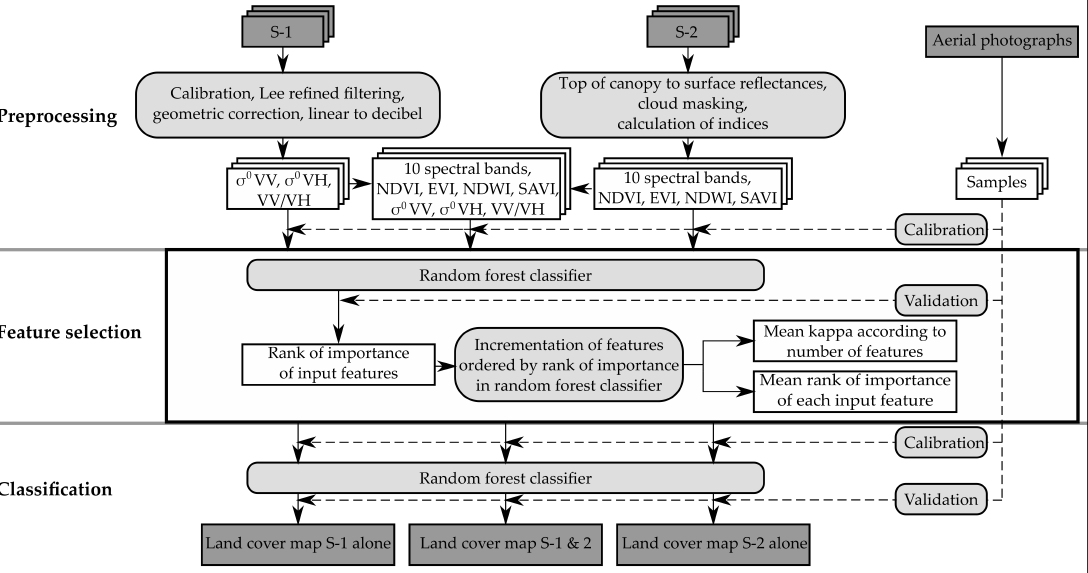
Figure 2. Flowchart of the image processing procedure. NIR = Near-infrared band. NDVI =Normalized difference vegetation index, EVI = Enhanced vegetation index, NDWI = Difference Water Index, SAVI = Soil adjusted vegetation